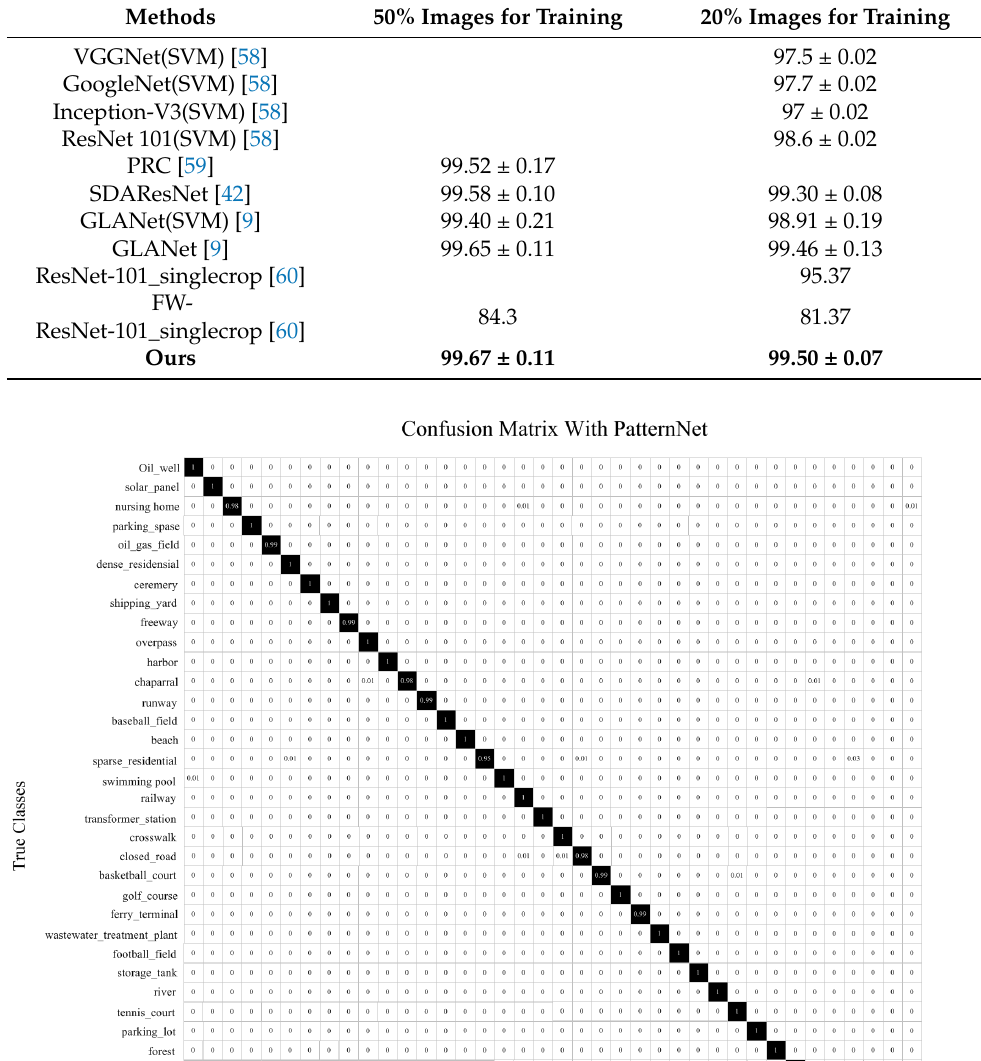
Table 4. The comparison of overall accuracy on PatternNet.